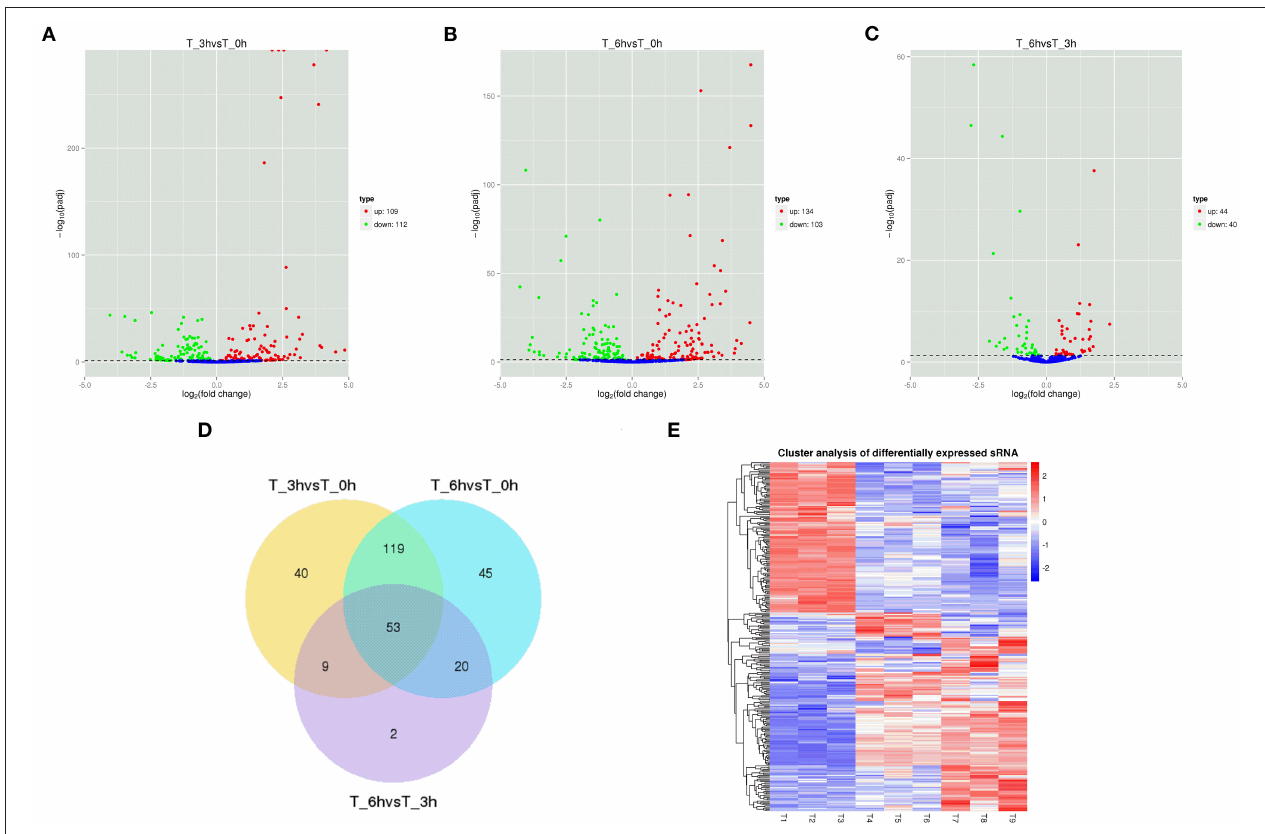
FIGURE 4 | Changes in lncRNAs expression during SE infection in duck granulosa cells. (A–C) Volcano plots showing up- and down-regulated lncRNAs of 3 vs. 0, 6 vs. 0, and 6 vs. 3 hpi group, respectively. (D) Venn diagram showing the number of overlapping differentially expressed lncRNAs between 0, 3, and 6 hpi. (E) Heat map of lncRNAs showing hierarchical clustering of DE-mRNAs between 0, 3, and 6 hpi. Up- and down-regulated lncRNAs are shown in red and blue, respectively.